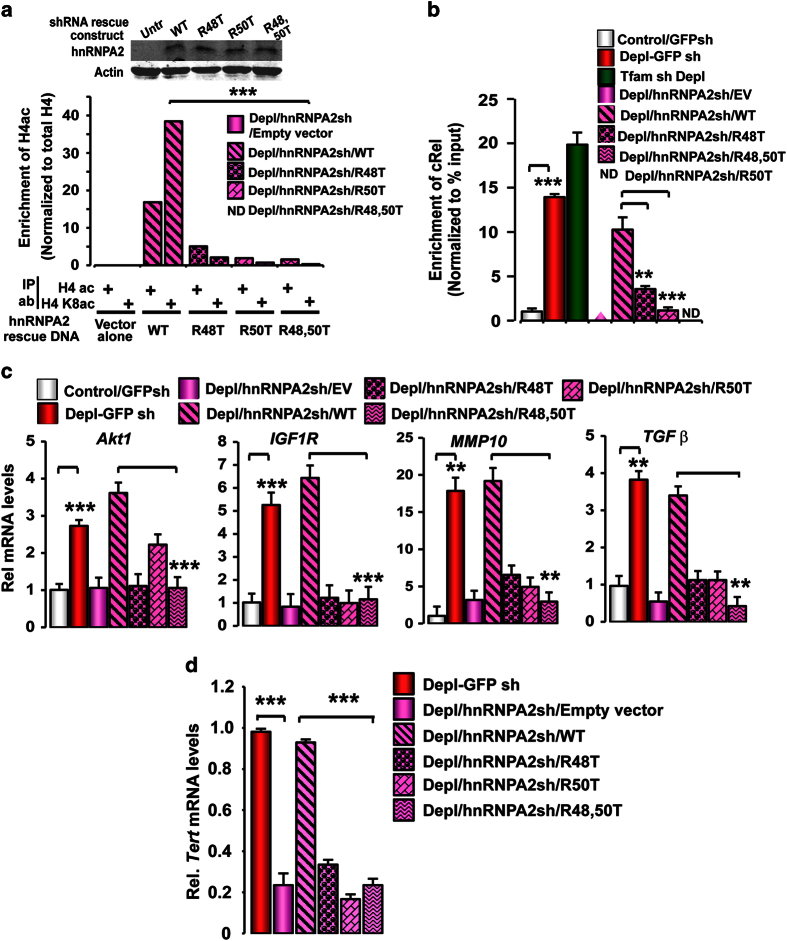
Functional role of hnRNPA2 KAT activity in stress-target gene transcription. (a,
b) Involvement of the hnRNPA2 KAT residues in H4 acetylation at Akt1
promoter detected by ChIP assay in PmtDNA-depl/hnRNPA2sh cells ectopically expressing
either the pMXs vector alone or hnRNPA2 WT, R48T, R50T and R48T/R50T mutants (Supplementary Figure S3D). Immunoblot (inset) showing similar
expression levels of all hnRNPA2shRNA rescue constructs in PmtDNA-depl/hnRNPA2sh cells.
(b) Association of stress-target factor, cRel at the Akt1 promoter in control,
PmtDNA-depl, PmtDNA-depl/hnRNPA2sh and in PmtDNA-depl/hnRNPA2sh cells ectopically
expressing hnRNPA2 WT and KAT mutants. (c) Transcript levels of target genes in
control, PmtDNA-depl, PmtDNA-depl/hnRNPA2sh and PmtDNA-depl/hnRNPA2sh expressing KAT
mutants in C2C12 cells (Supplementary Figures S3D and S4;
Supplementary Table S1). (d) Tert
transcript levels in control, PmtDNA-depl, PmtDNA-depl/hnRNPA2sh and
PmtDNA-depl/hnRNPA2sh cells expressing WT and KAT mutant cells. Data are represented as
mean±s.d.